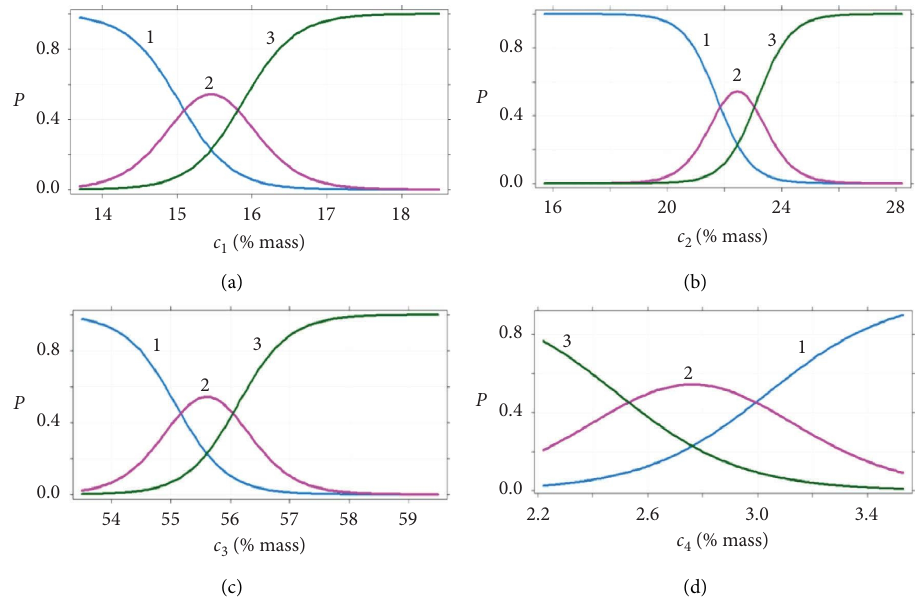
Figure 6: Probabilities P of responses of diferent smell categories in dependence on content of (a) protein c (d) salt c 4 , mass fractions, %. Each plot is calculated at contents of other main components equal to their observed mean values in Table 4. Te line numbers are as in Figure